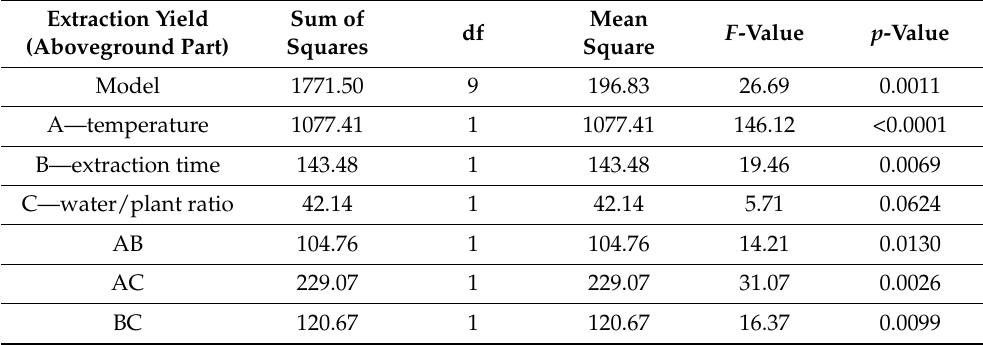
Table 2. Variance analysis for the extraction yields of the aboveground part and roots of O. mutabilis